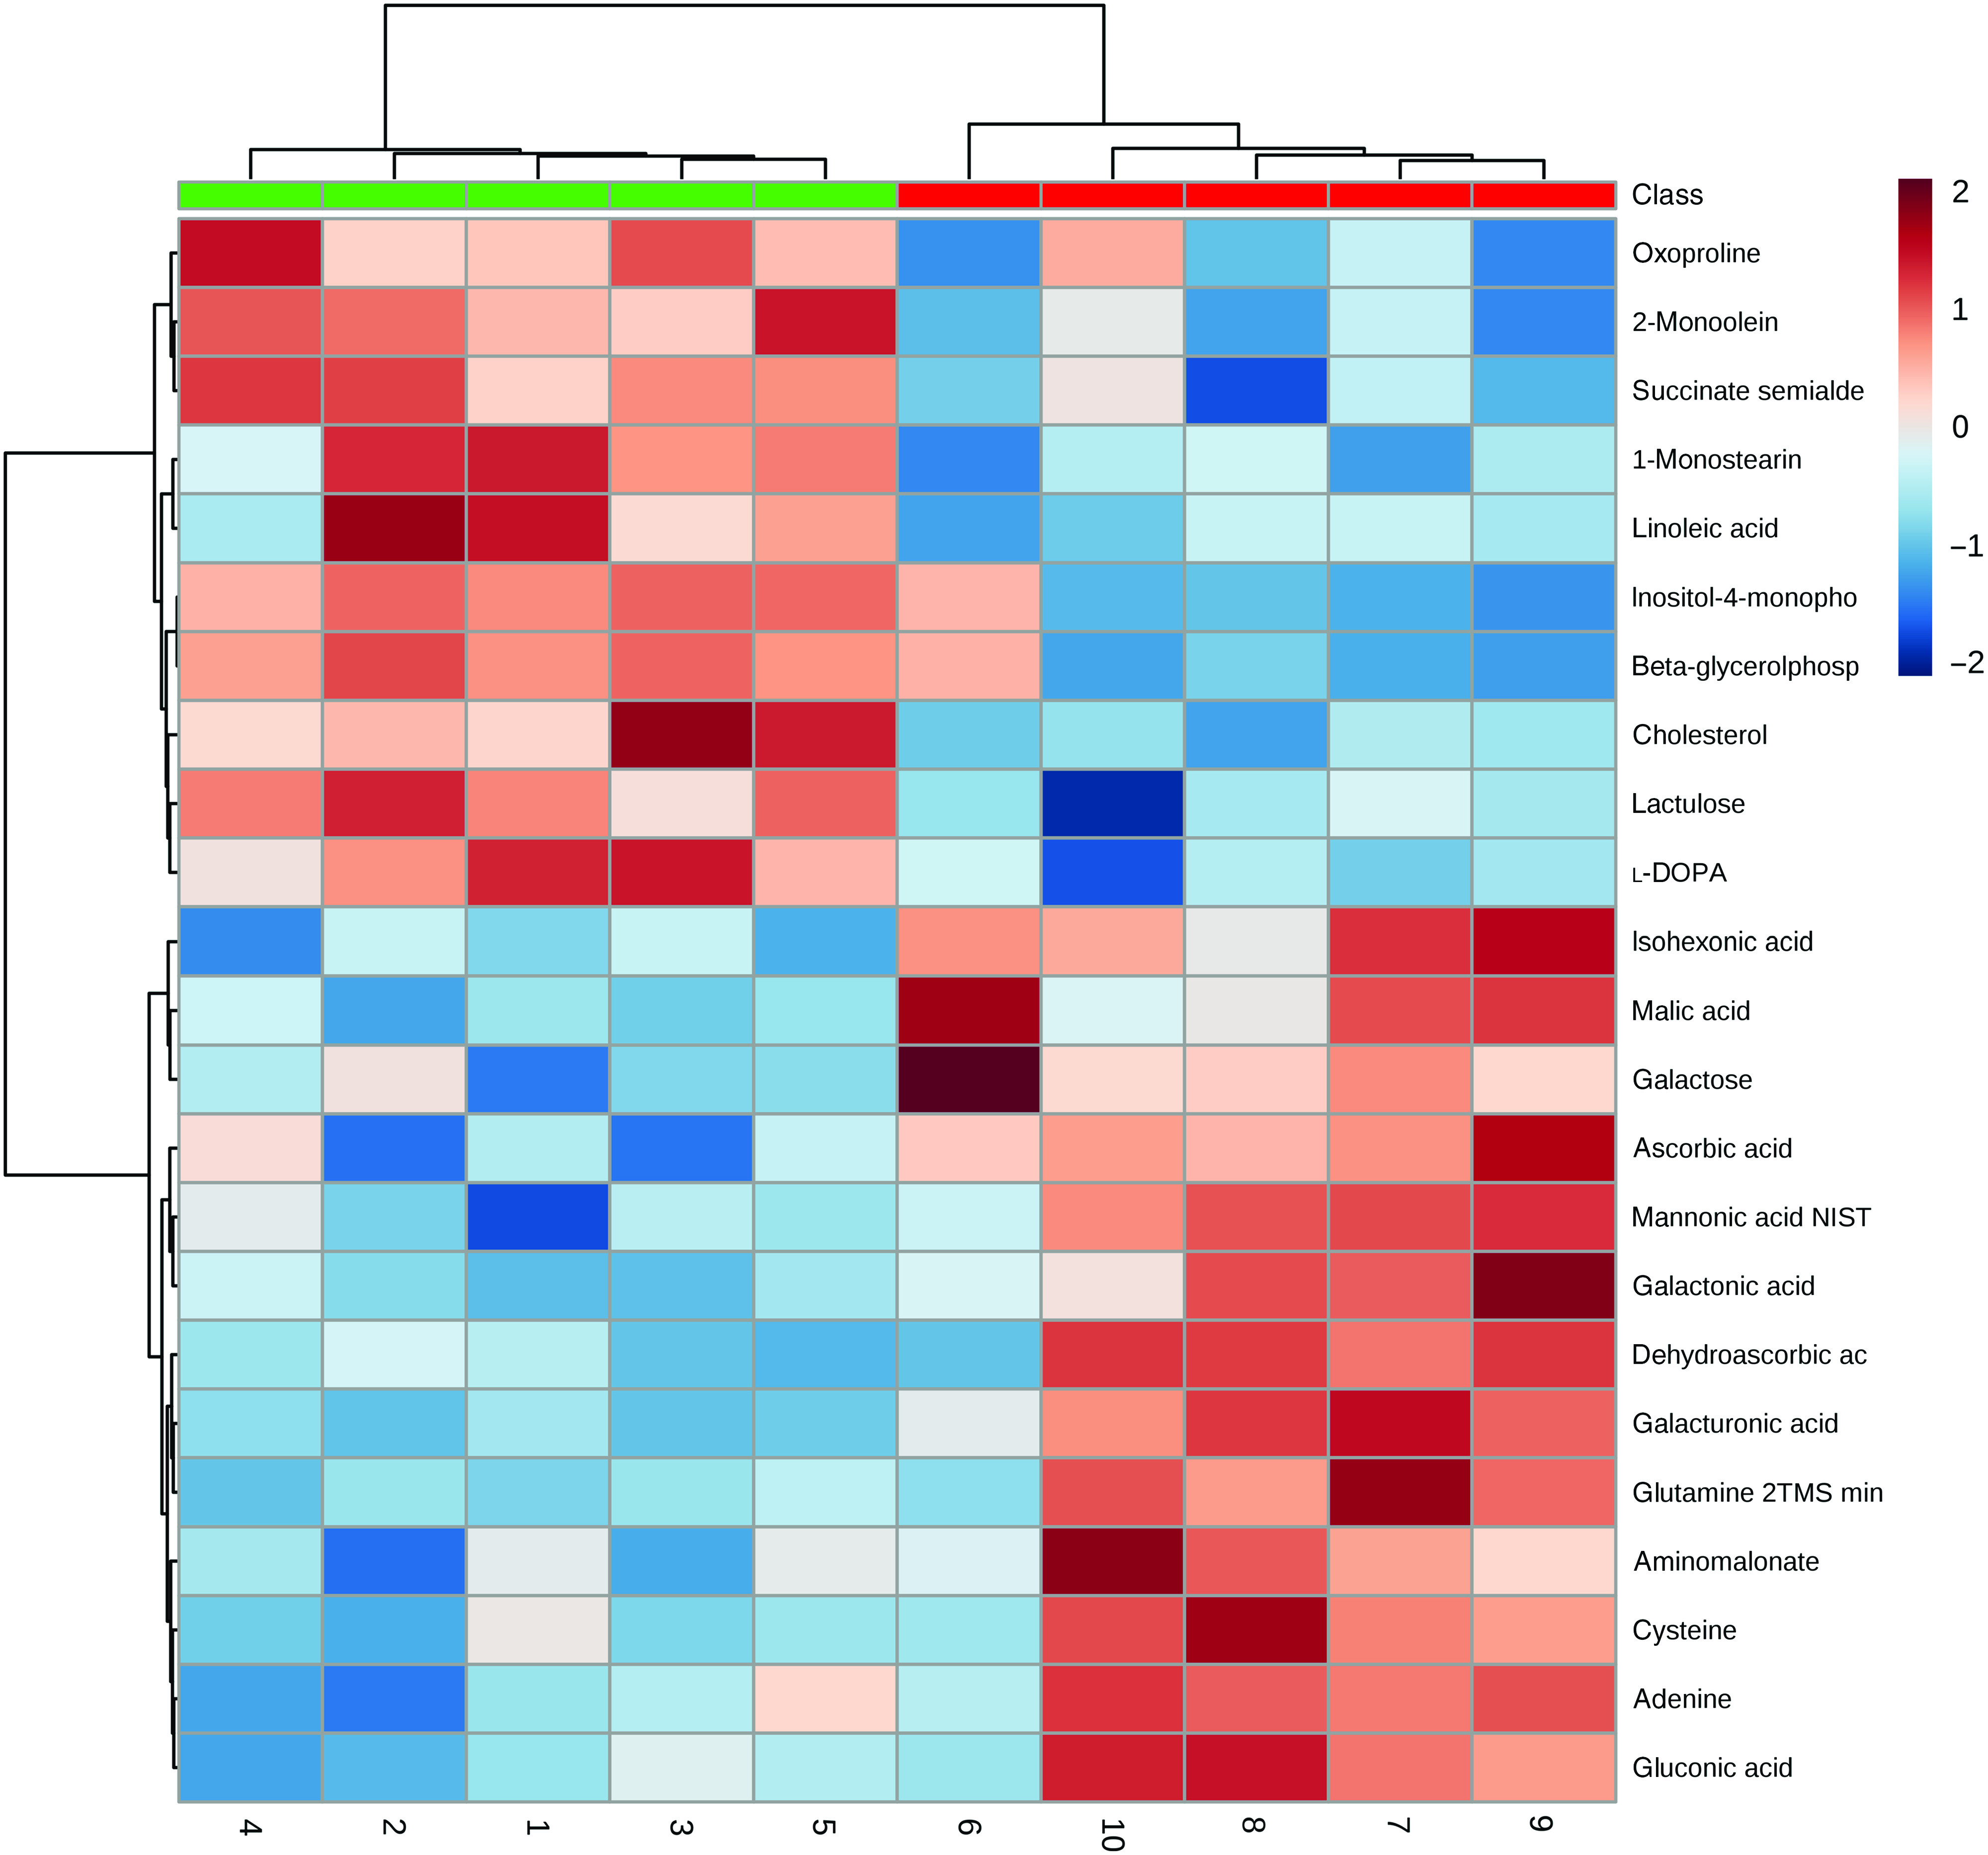
Heat map and hierarchical clustering of twenty-three hepatic metabolites significantly affected at day 7 post-diquat challenge in nursery pigs. Class: , negative control without diquat challenge or dietary selenium supplementation; , positive control with diquat challenge without dietary selenium supplementation.